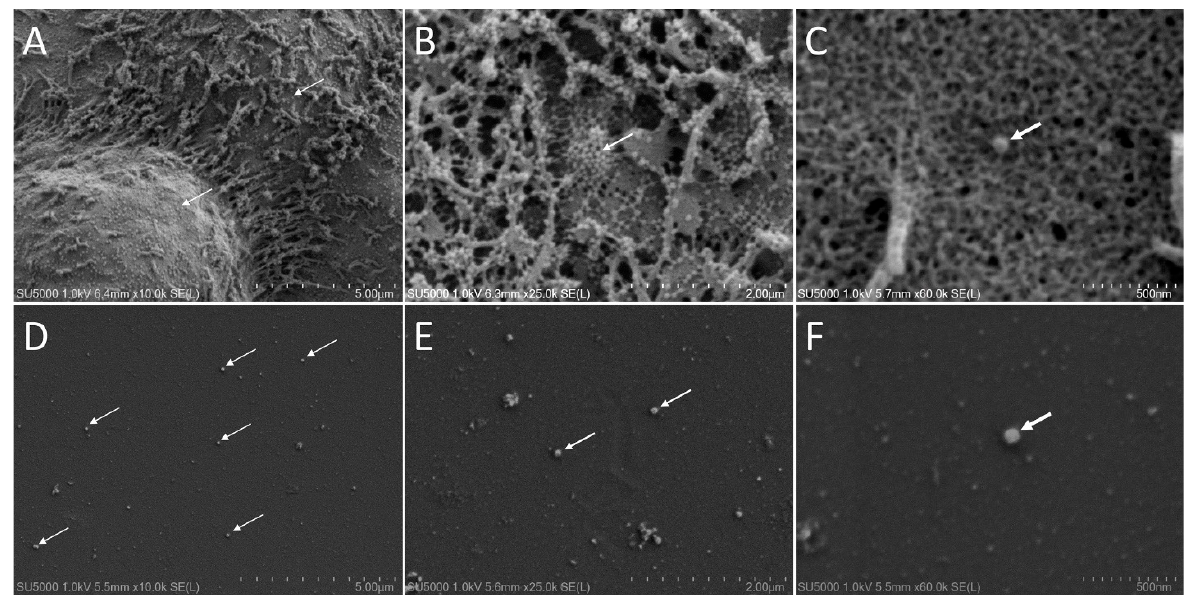
Figure 1. Scanning electron microscopy of SARS-CoV-2-like particles. ( A – C ): Secondary electron detector and 1 kV acceleration voltage used for imaging whole SARS-CoV-2 VeroE6-infected cells after fixation, dehydration and HDMS drying. ( D – F ): Secondary electron detector and 1 kV acceleration voltage used for imaging SARS-CoV-2 VeroE6 infected cell supernatants, after fixation, dehydration and HDMS drying. Arrows point to SARS-CoV-2